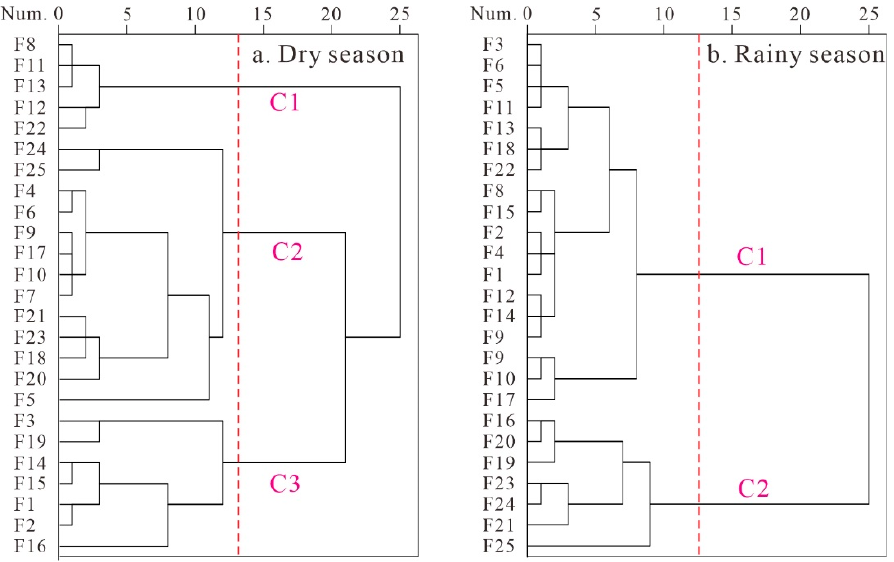
Figure 4. Hierarchical cluster tree of sampling sites in the Fuhe River watershed by cluster analysis. Table 5. Mean values with standard deviation (SD) for heavy metals and other parameters in different clusters of the Fuhe River watershed,